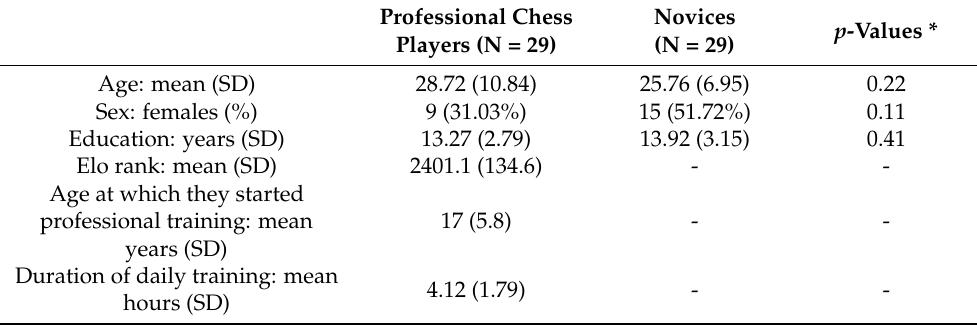
Table 1. Demographic and chess training characteristics of professional chess players (N = 29) and novice participants (N =